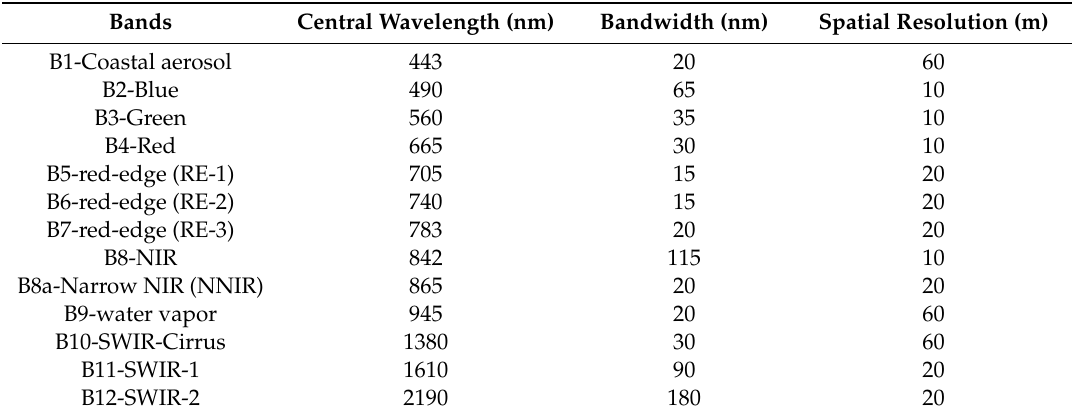
Table 1. Multi-Spectral Instrument (MSI) data from Sentinel-2.